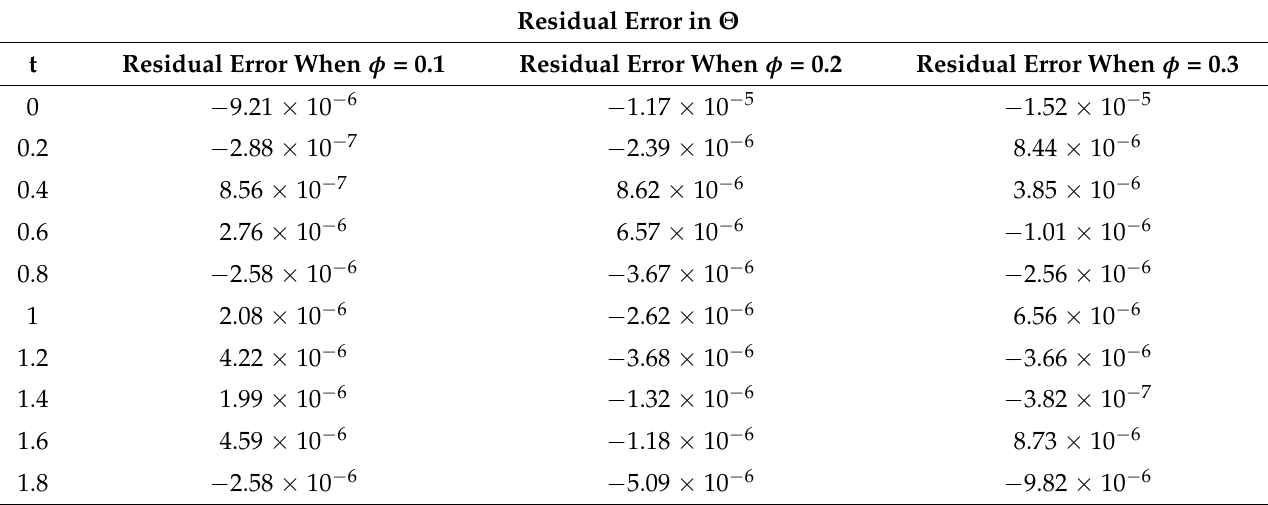
Table 17. The residual error in Θ when volume fraction φ